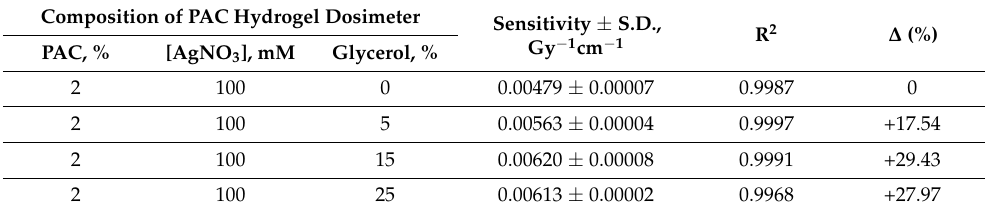
Figure 6. Radiation dose sensitivity of PAC hydrogel dosimeter as a function of glycerol concentration (%). The solid line is a guide for the eye obtained using a basis spline function. The error bars represent the one standard deviation of the mean values. Table 3. Radiation sensitivity, correlation coefficient, and the percentage variation of response of PAC hydrogel dosimeters prepared using different glycerol